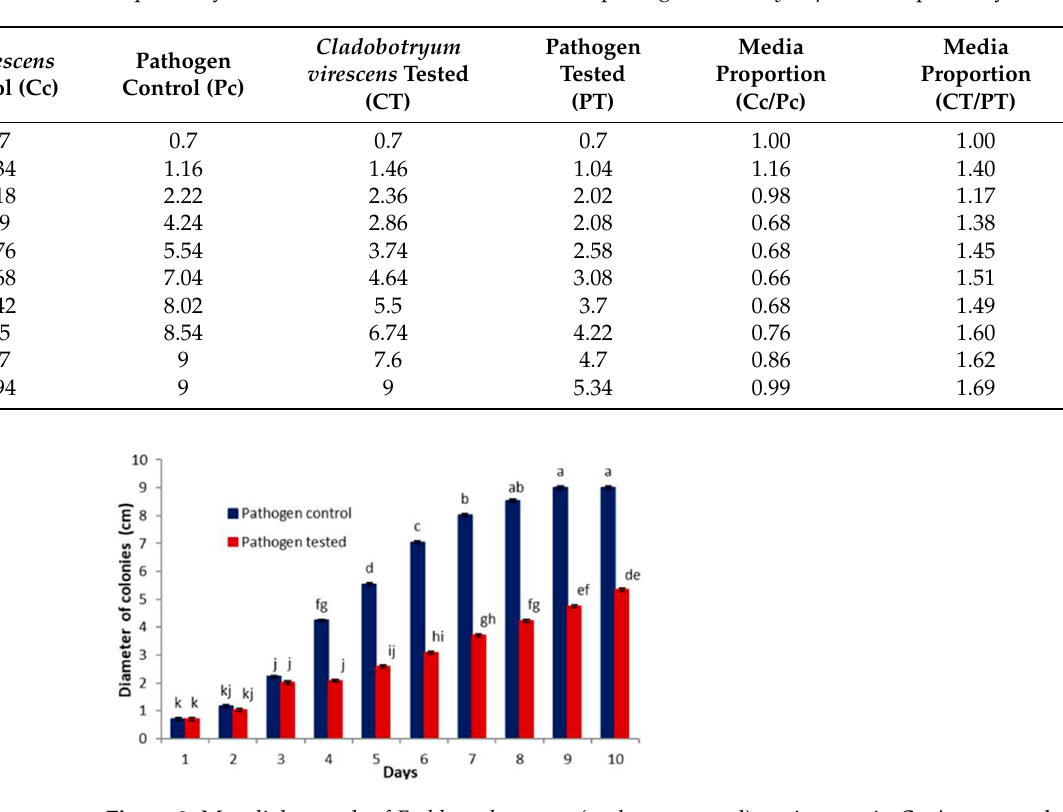
Figure 2. Mycelial growth of F. chlamydosporum (pathogen tested) against strain C. virescens and the control for ten days in dual culture. Mean and standard deviation is expressed in the error bar ( n = 5). Different letters indicate a significant difference (Tukey test, p ≤ 0.05). Table 5. Competition for nutrients. In vitro inhibition activity of C. virescens on mycelial growth (cm) of A. brassicicola from day 1 to 10 on OA medium. Media proportion was calculated as: mycelial growth diameter of C. virescens / A. brassicicola . CT and Cc refer to tested and control C. virescens , respectively. Pc and PT refer to tested and control pathogen A. brassicicola ,